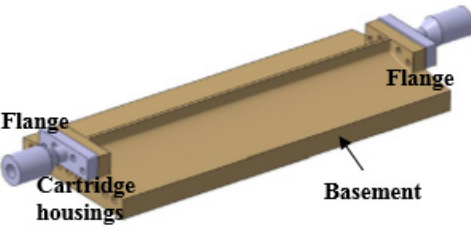
Figure 6. MTP breadboard: sketch of the test article.